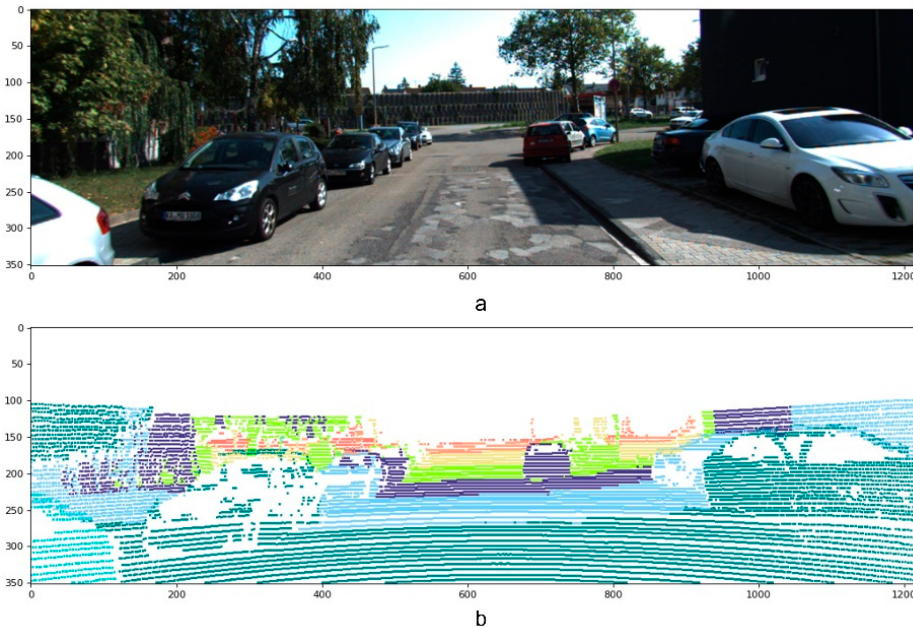
Figure 1. Sparse point cloud example: ( a ) reference RGB image; ( b ) sparse depth map color-encoded and enlarged for better visualization.